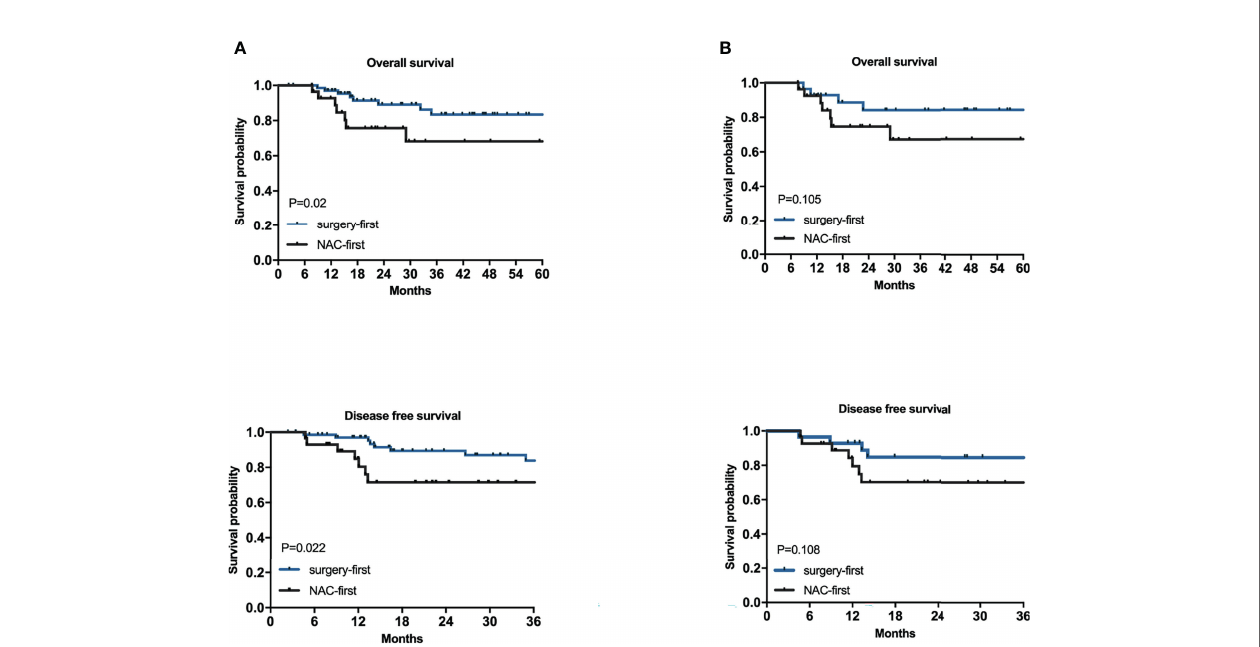
FIGURE 2 | The relationships between NAC and the prognosis of HAS. Kaplan – Meier survival plots for NAC- fi rst and surgery- fi rst groups for 100 patients (A) and for after 1:1 PSM of 56 patients (B) . P values were calculated by the log-rank